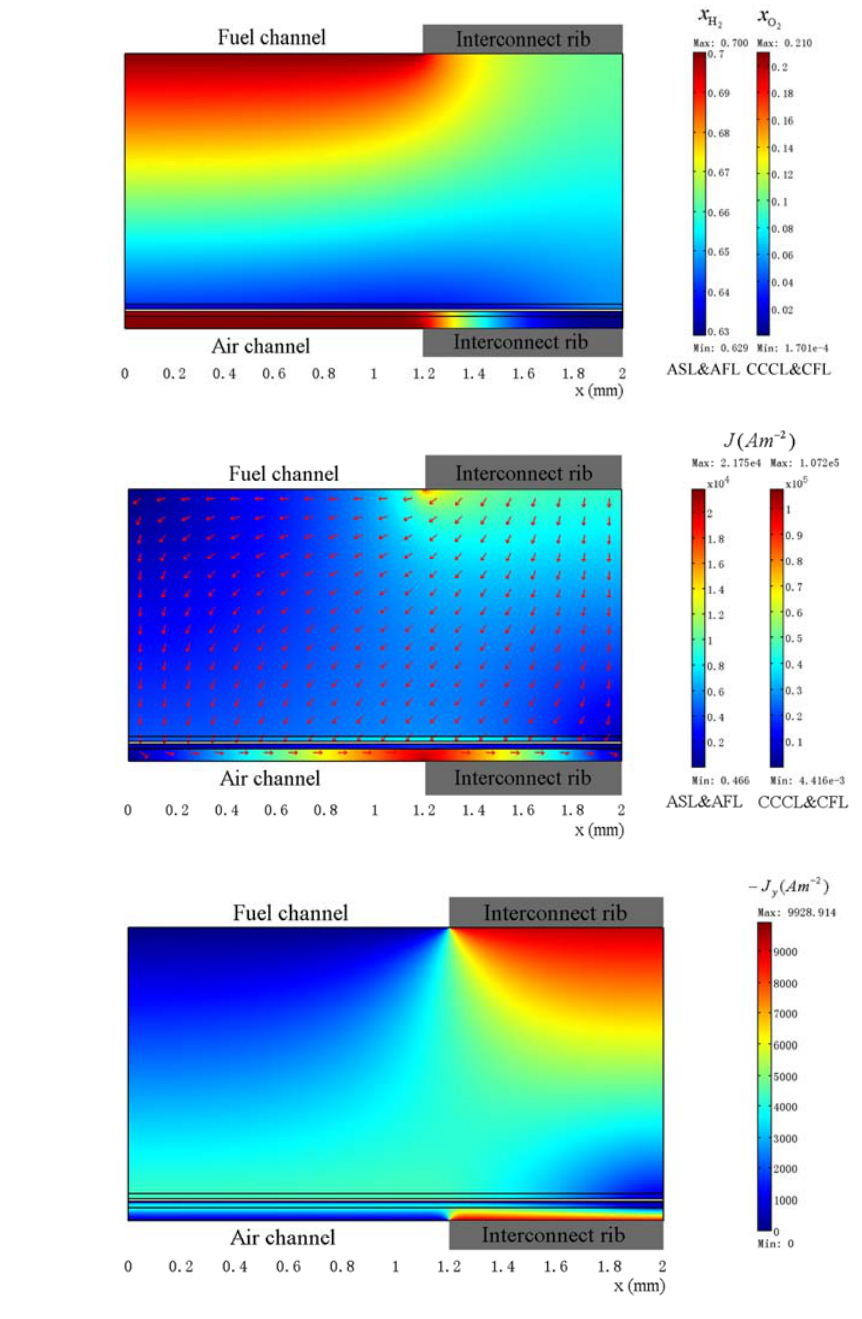
Figure 5. The distributions of physical quantities when the CCCL layer thickness is 50 μ m: (a) hydrogen and oxygen molar fractions; (b) total electronic current density and current flux vector; (c) the y component of the current flux